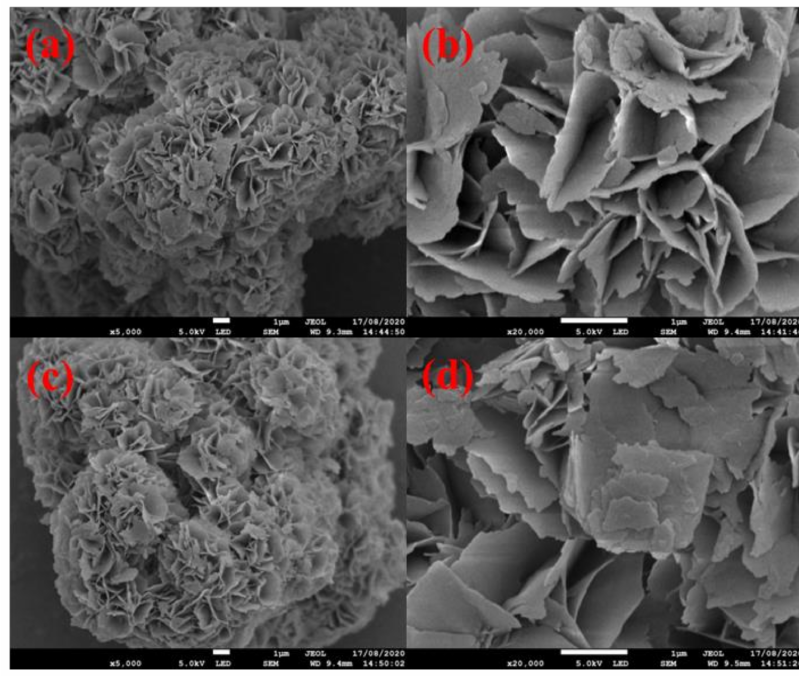
Figure 8. ( a , b ) SEM images of Mg(OH) 2 , ( c , d ) SEM images of